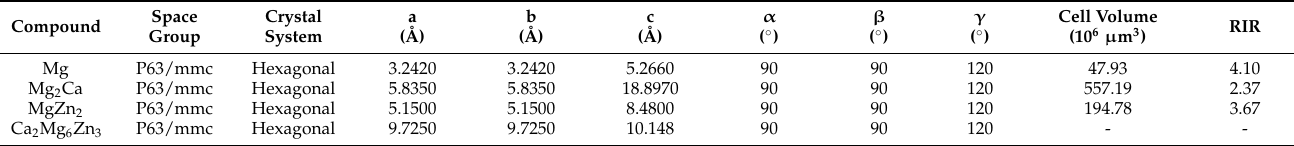
Table 3. La tt ice parameters of the Mg–0.5Ca–xZn alloy phases.